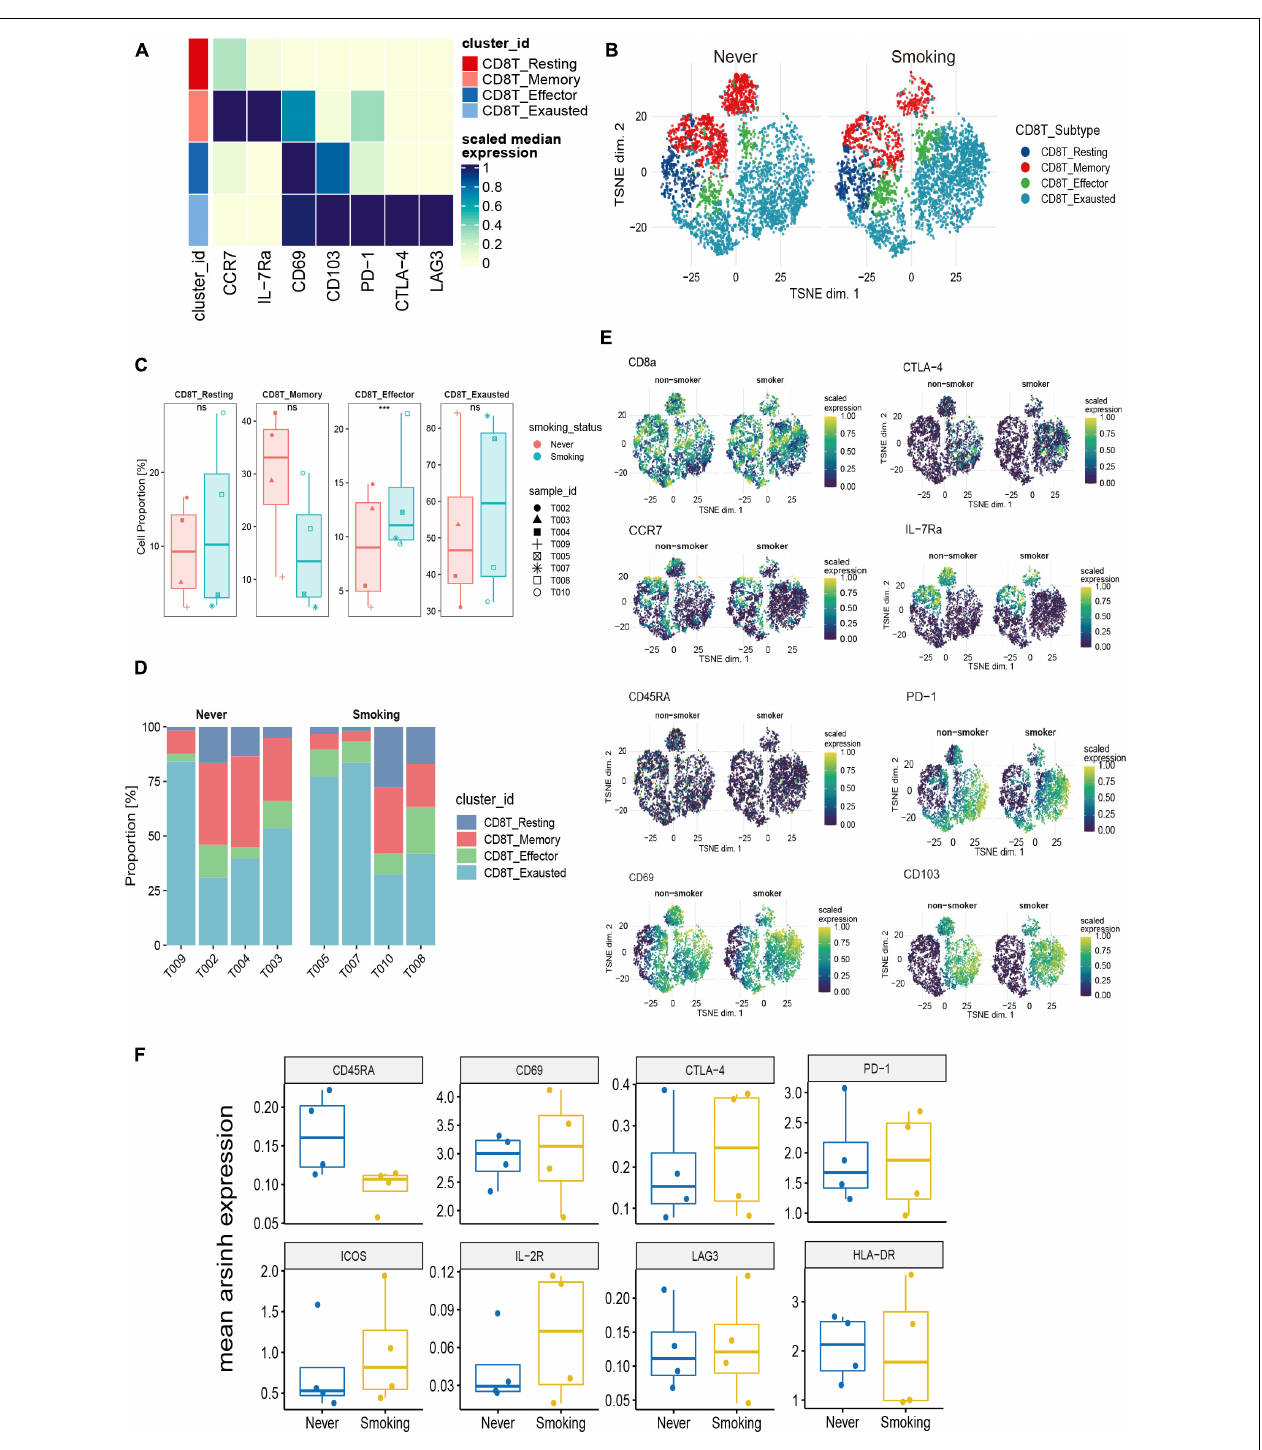
FIGURE 7 | Features of CD8 + T cells in NSCLC with different smoking status. (A) Heatmap of the median marker intensities of the multiple lineage markers in the 4 CD8 + T cell populations obtained by manual merging of the 30 metaclusters generated by FlowSOM. The heat represents the median of arcsinh and 0–1 transformed marker expression calculated over cells from all the samples. (B) t-SNE plot showing the overall distribution of different CD8 + T cell clusters between previous/current smokers and non-smokers. (C) Box plot comparing the relative abundance of each CD8 + T cell cluster between different smoking status groups. Box plot center and box correspond to median and IQR, respectively. Different shapes were used to represent each patient. * p < 0.05; ** p < 0.01; *** p < 0.001; **** p < 0.0001; ns, not significant. (D) Bar plot showing the relative abundance of different CD8 + T cell types in each sample, faceted by smoking status. (E) t-SNE plots of markers used to annotate CD8 + T subgroups in different groups. (F) The expression level of several functional markers in different groups.